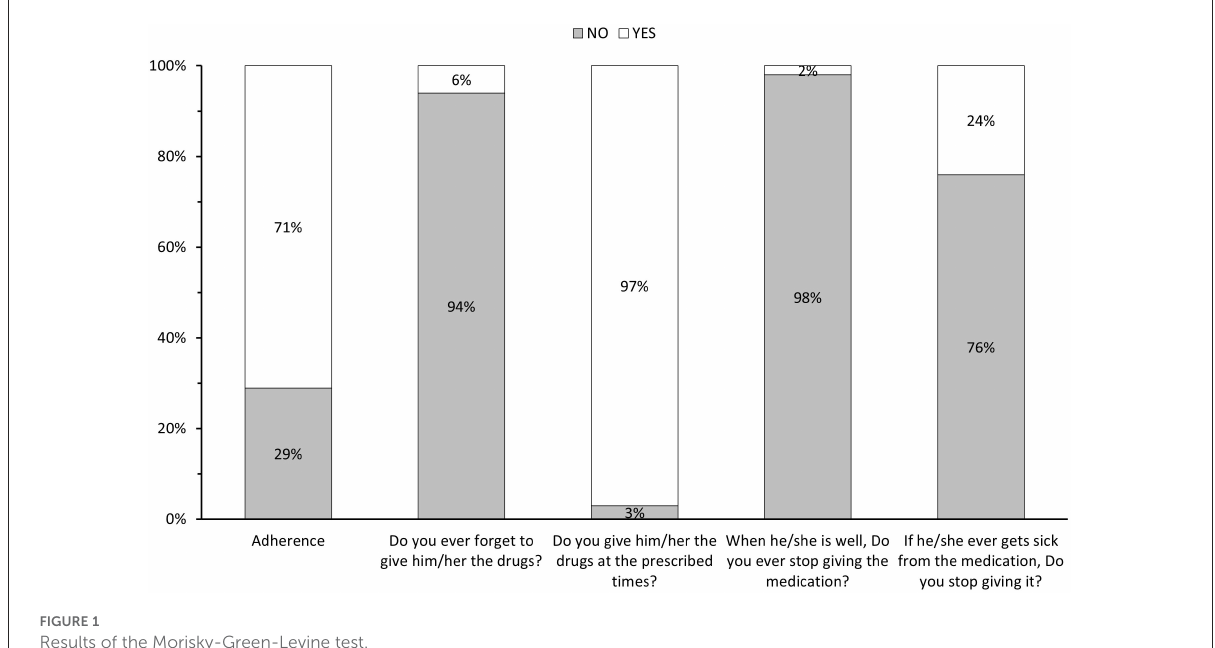
FIGURE1 Results of the Morisky-Green-Levine